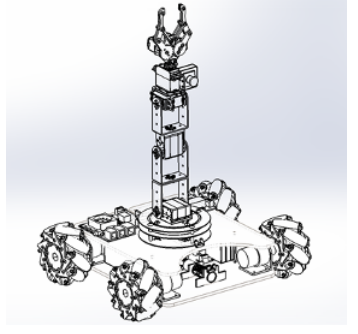
Fig. 1. Overall structure of the robot.